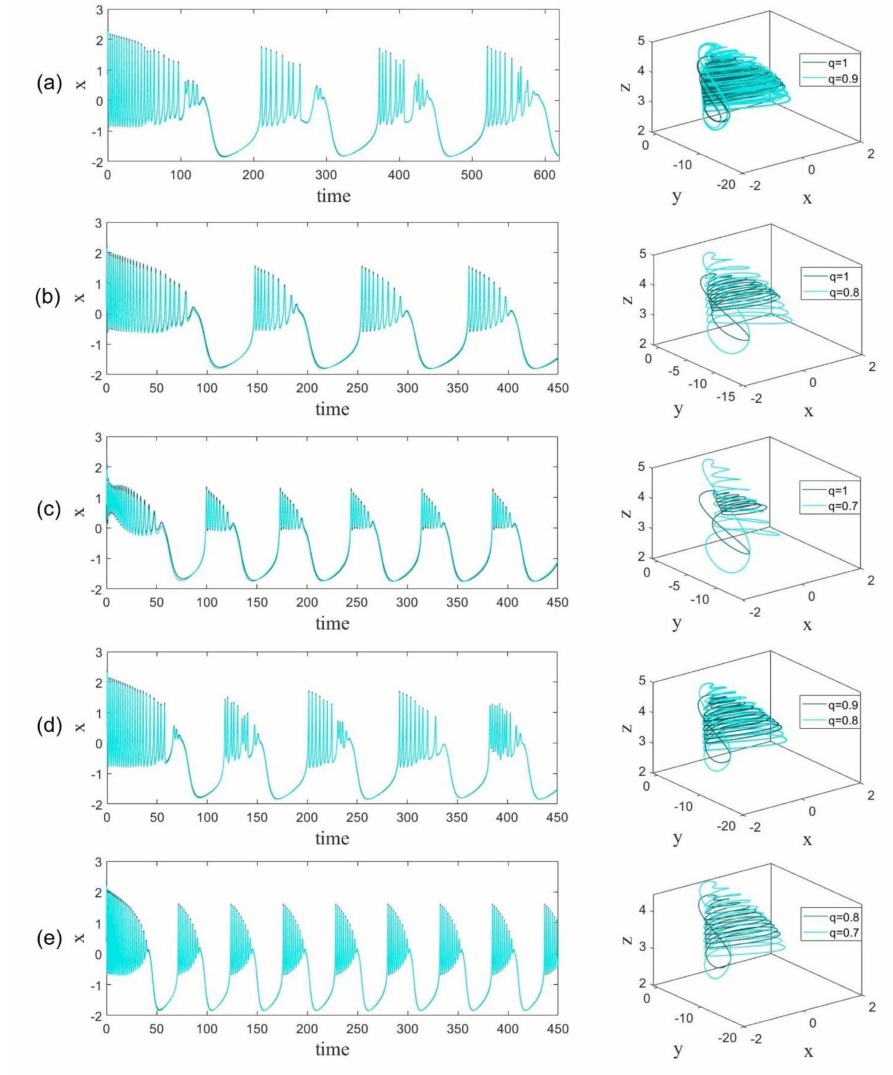
Figure 7. Time series of membrane potential and attractors of the neurons in each layer in the near synchronization manifold ( (cid:101) = 12 and σ = 0.1): ( a ) q 1 = 1, q 2 = 0.9; ( b ) q 1 = 1, q 2 = 0.8; ( c ) q 1 = 1, q 2 = 0.7; ( d ) q 1 = 0.9, q 2 = 0.8; ( e ) q 1 = 0.8, q 2 =